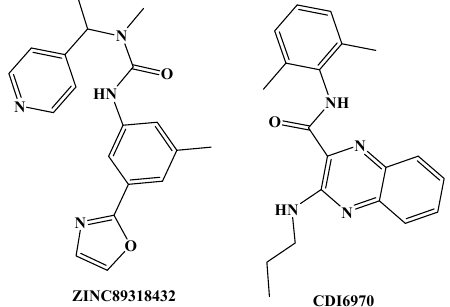
Figure 6. Two compounds with great structural difference from BMS22 were obtained based on